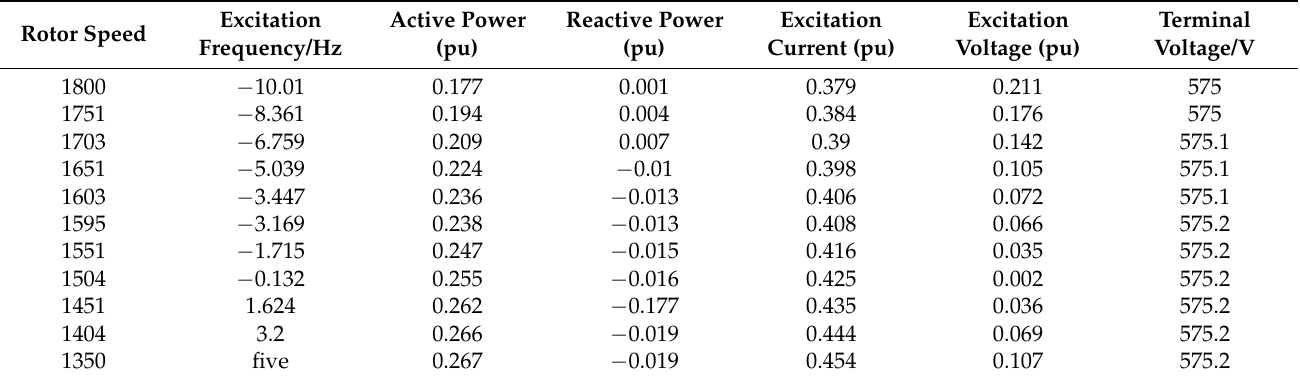
Table 4. The change in rotor speed at a given power at a wind speed of 9 m/s.